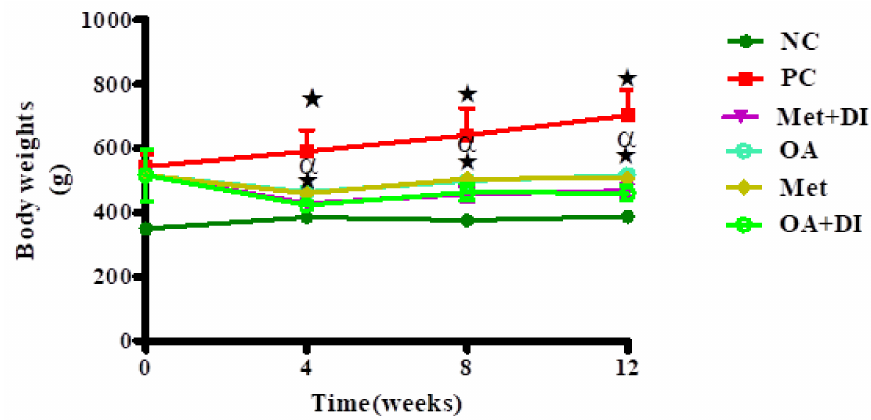
Figure 1. Effects of OA on body weights on rats that were treated OA with and without diet intervention during treatment period. Values are presented as standard error of mean ± SEM. (cid:70) = p < 0.05 denotes comparison with NC; α = p < 0.05 denotes comparison with PC.